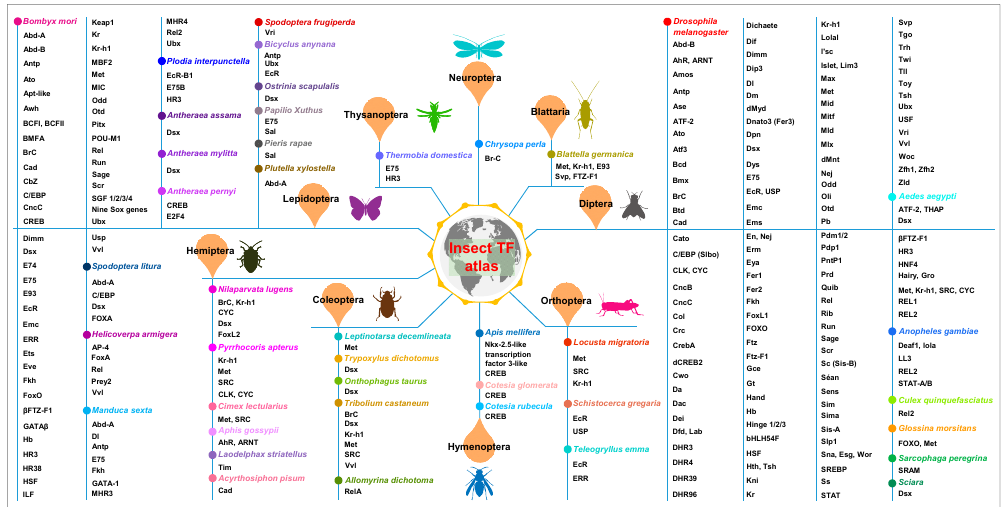
Figure 1. The insect transcription factor (TF) atlas, including the well-studied TFs and their related